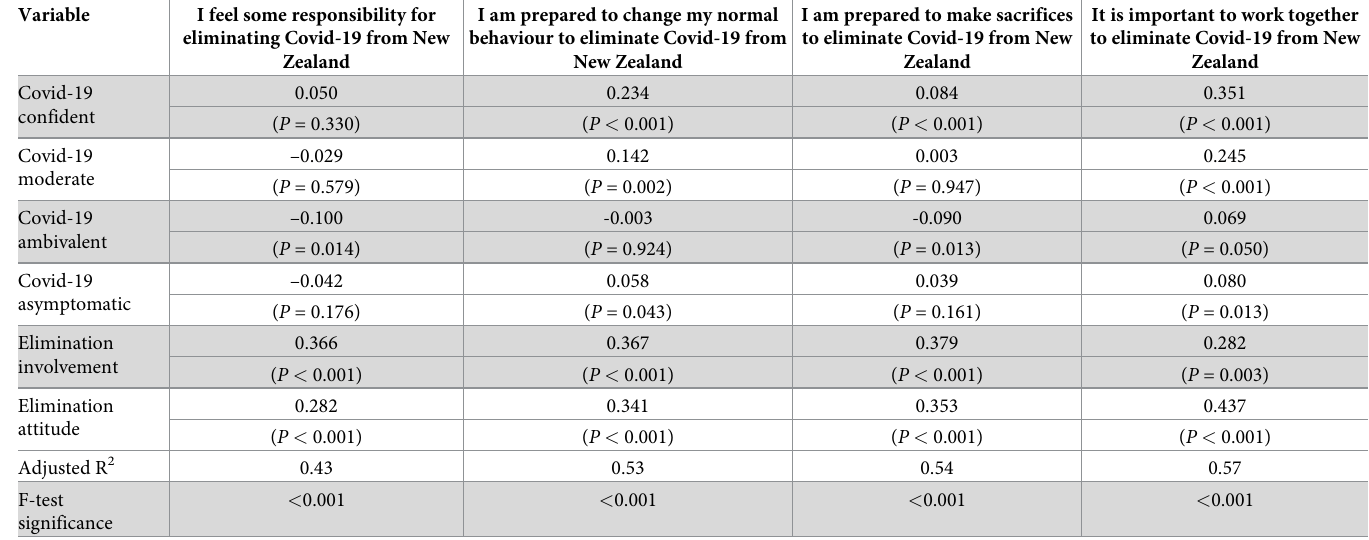
Table 11. Estimates of standardised parameters for sense of responsibility, willingness to change behaviour, willingness to make sacrifices, and willingness to work with others to eliminate Covid-19. Variable